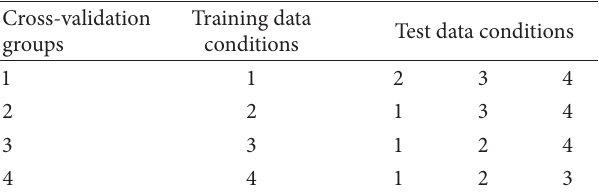
Figure 17: The classification result of the third cross-validation group. Table 3: The rolling bearing data composition under variable con- ditions for cross-validation.